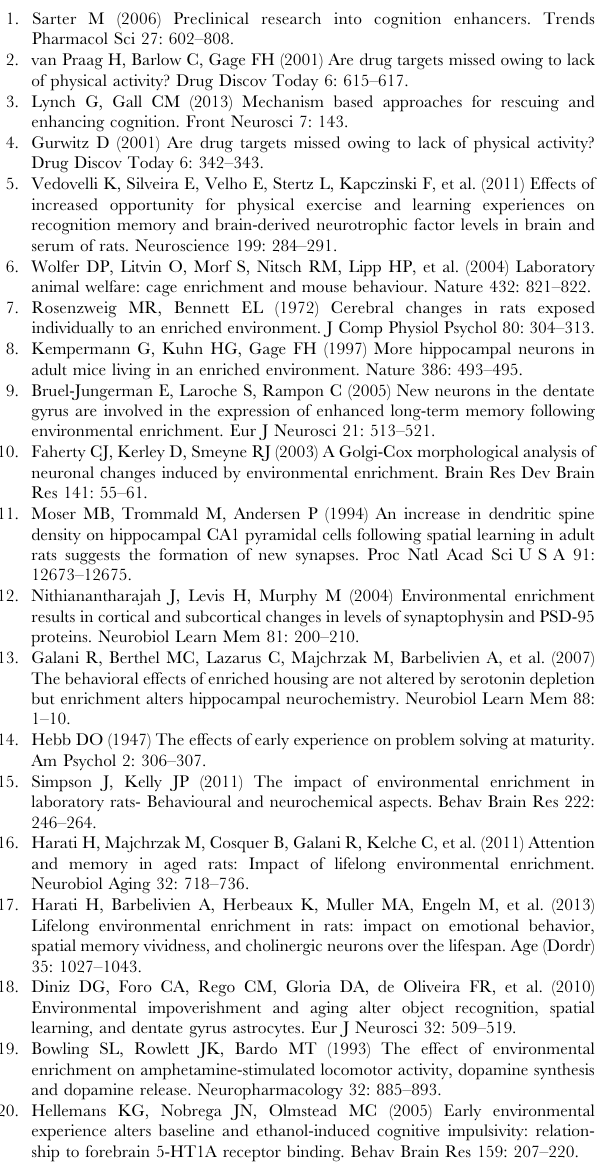
Figure S6 Protein levels of pGSK-3 b and b -catenin in the dorsal hippocampus. Western Blot analysis showing protein levels of pGSK-3 b (A), and b -catenin (B) of the three experimental groups. Data was normalized relative to the housekeeping protein b -actin. Bars indicate mean ( + SEM) per group. One-way ANOVA revealed no statistical differences between the experi- mental groups. Figure S7 Protein levels of ERK2 and pCREB in the dorsal hippocampus. Western Blot analysis showing protein levels of ERK2 (A) and pCREB (B) of the three experimental conditions. Data was normalized relative to the housekeeping protein GAPDH. Bars indicate mean ( + SEM) per